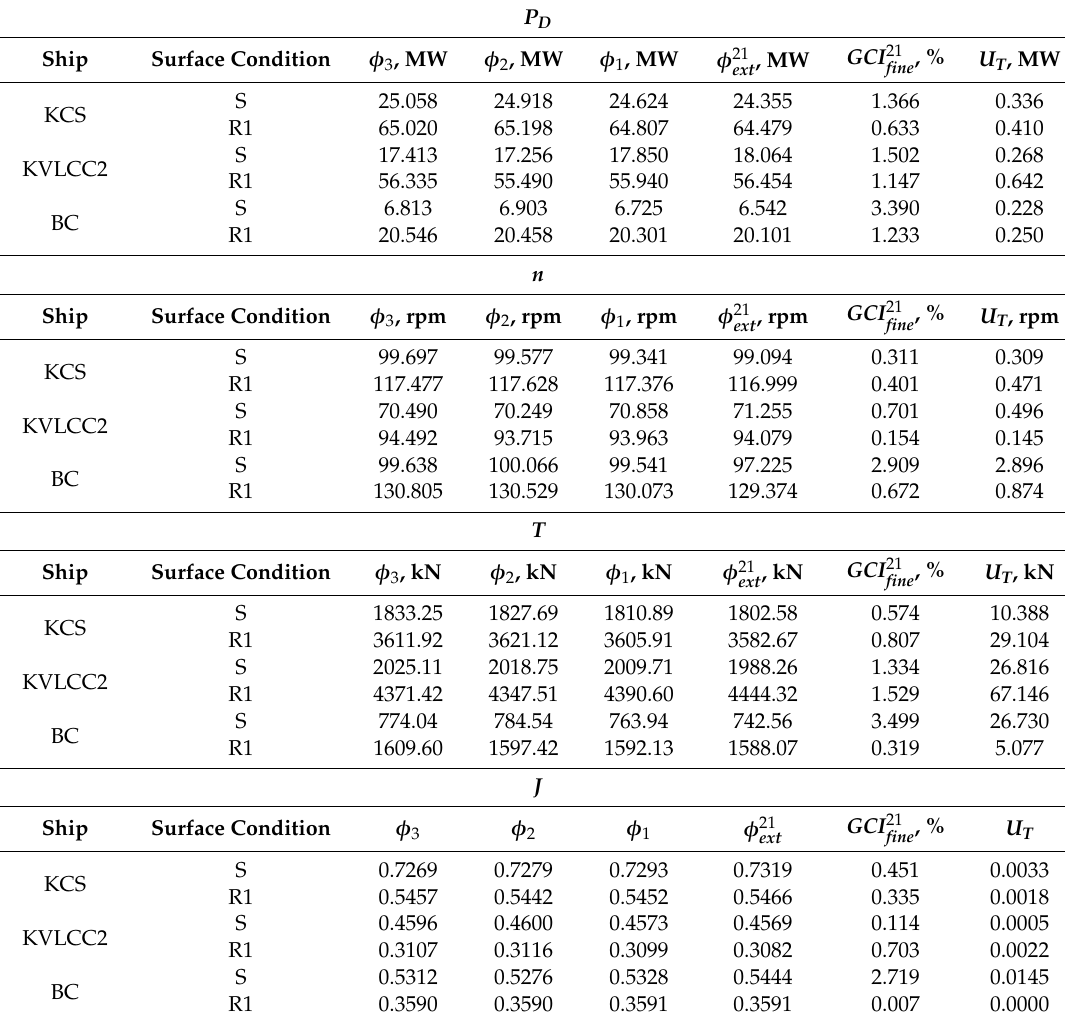
Table 8. The obtained temporal uncertainties in the prediction of P D , n , T and J .